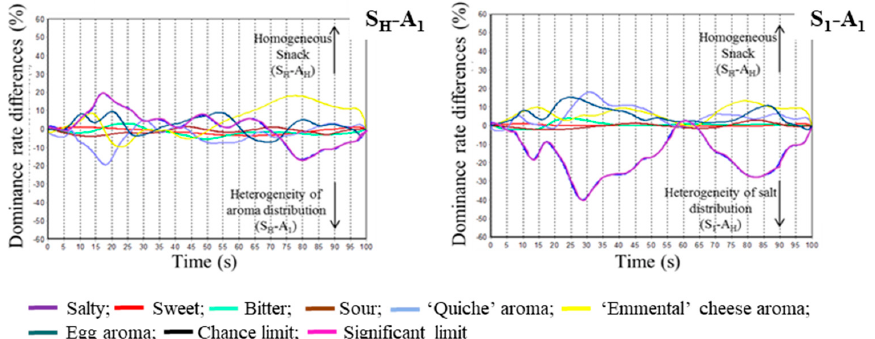
Figure 8. TDS (Temporal Dominance of Sensations) difference curves of products with homogene- ous salt and added aroma distribution (S H -A H ) and products with heterogeneous added aroma distribution (S H -A 1 ) or heterogeneous salt distribution (S 1 -A 1 ).